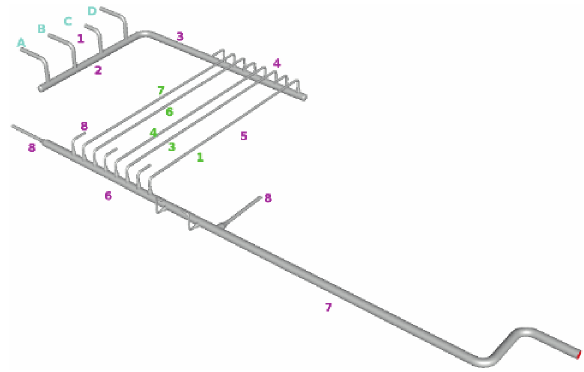
Figure 1: Geometry of piping